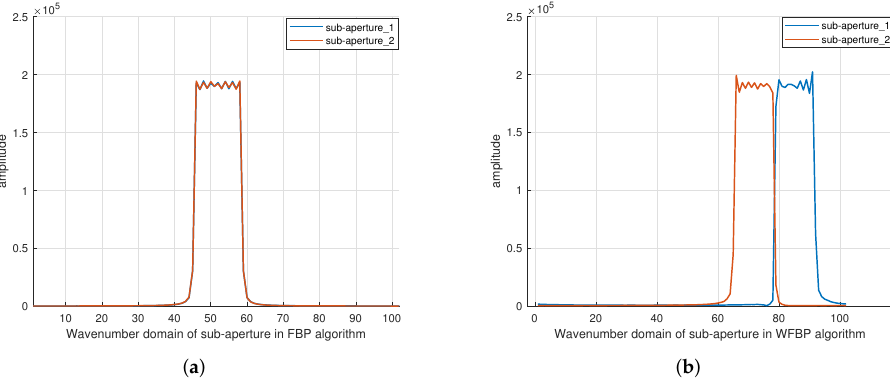
Figure 2. Wavenumber-domain spectrum of WFBP and FBP algorithm: ( a ) FBP; ( b ) WFBP. The wavenumber-domain spectra obtained by FBP and WFBP algorithms for the same target are drawn together. The blue and red lines are the wavenumber-domain spectra of sub-apertures 1 and 2. Figure 2a is the wavenumber-domain spectrum in FBP. Sub-aperture 1 and 2 have the same spectral positions and coincide. The position of the wavenumber-domain spectrum does not change with the movement of the sub-aperture.